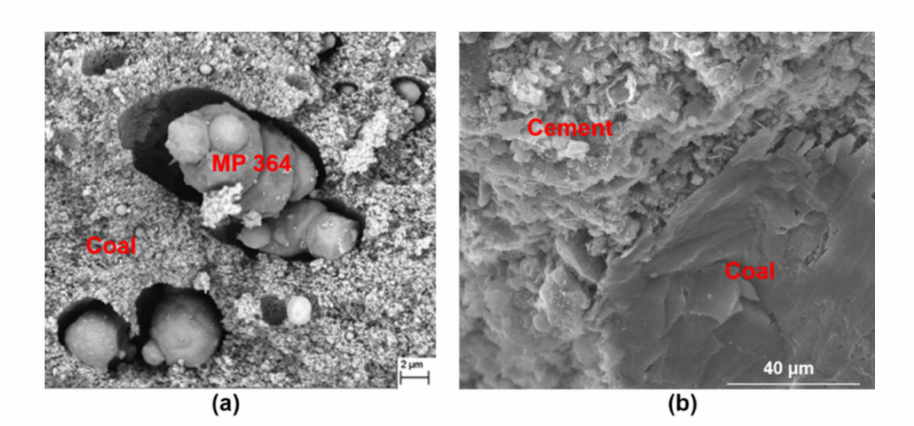
Figure 5. The microstructure of the coal-grout composite after the 28th day: ( a ) coal-chemical grout composite; ( b ) coal-cement grout composite.